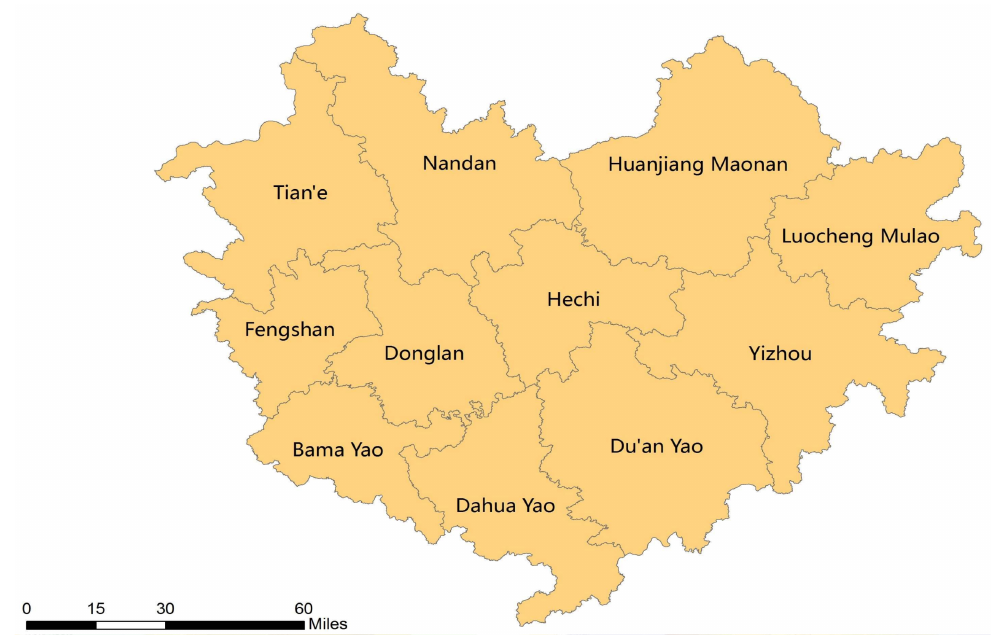
Figure 2. Eleven counties in Hechi city in Guangxi, China. Table 1. Indicators of the old-age